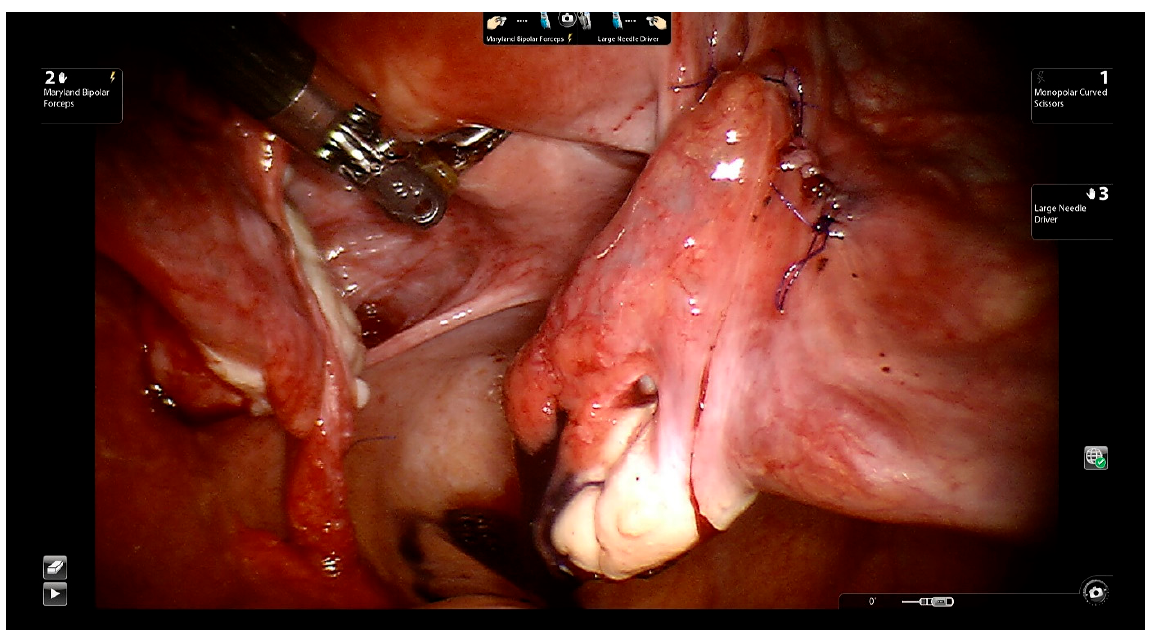
Figure 6. Suturing of the mucosal and muscular layers of the tubal segments with interrupted 5-0 PDS.